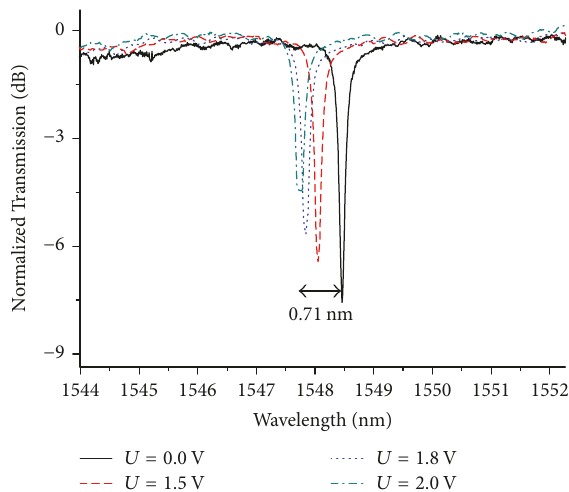
Figure 11: The static modulation of the micro-nano SOI micro-ring electro-optic